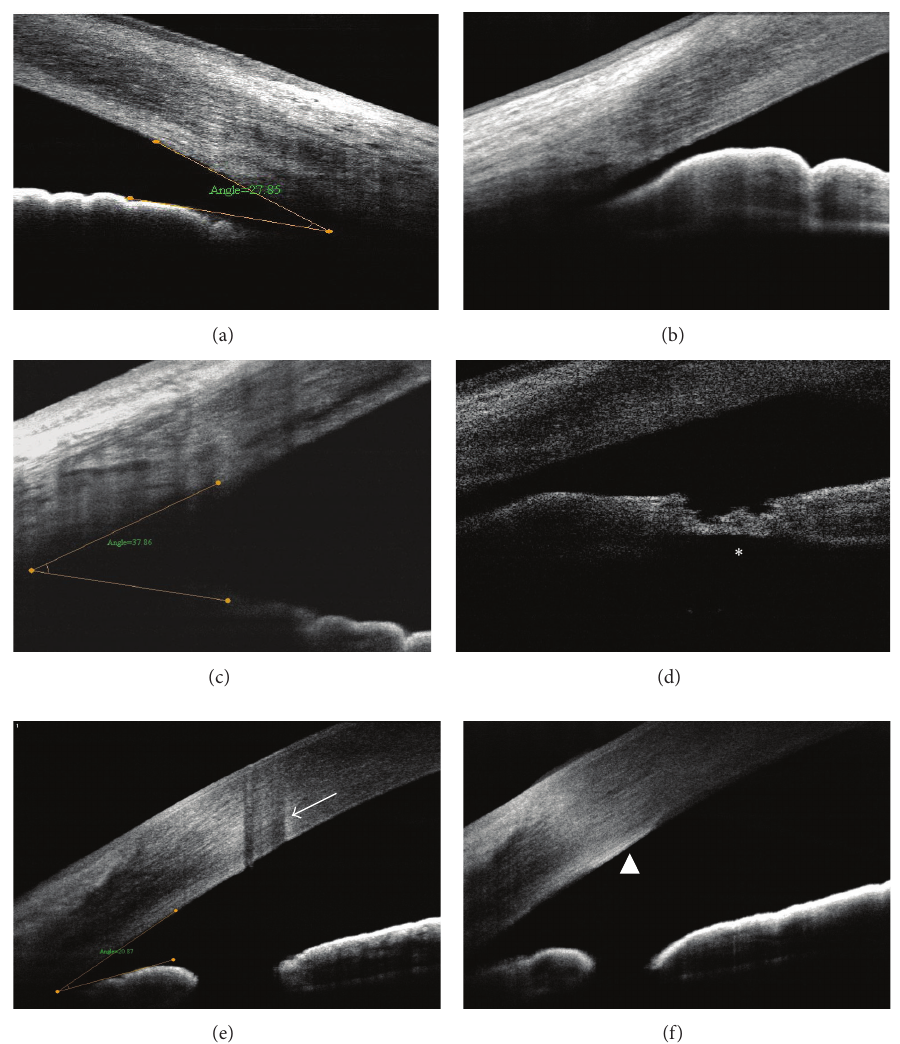
Figure 11: Angle assessment by AS-OCT. Narrow occludable angle (a), plateau iris configuration (b), open angle (c), incomplete laser iri- dotomy (d), stromal damage (e), and thickened Descemet’s membrane after laser iridotomy